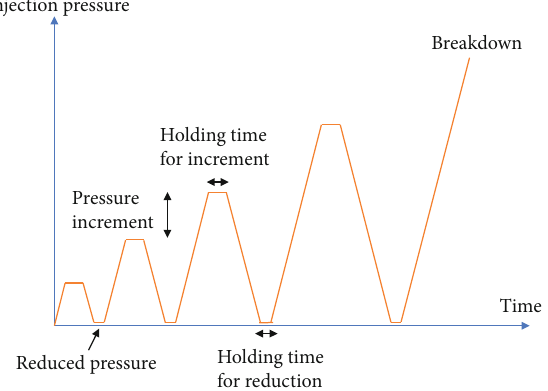
Figure 4: Schematic of the stepped pressure injection method in the cyclic injection tests.